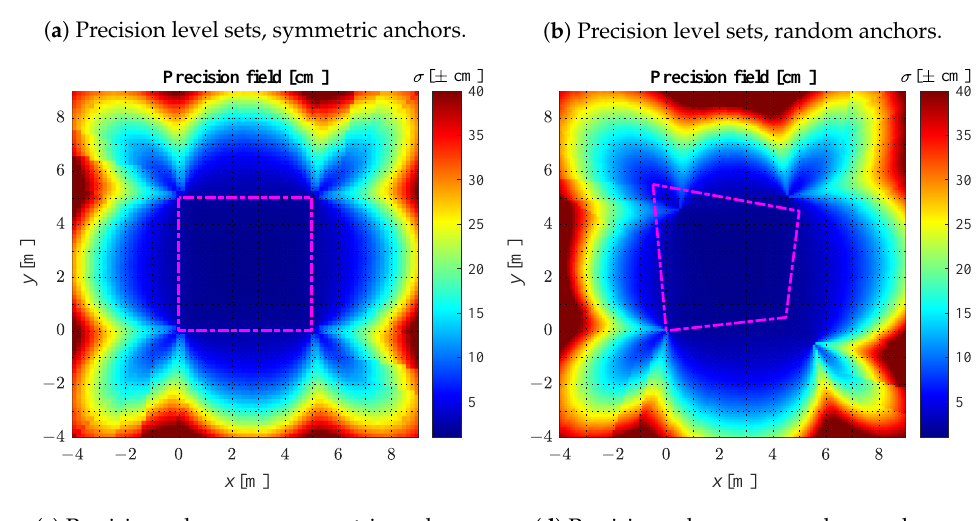
( c ) Precision colourmap, symmetric anchors. ( d ) Precision colourmap, random anchors. Figure 5. Precision level sets and colourmaps for symmetric and random anchors. The magenta trapezoid is the convex hull of four anchors (modified from [38], with